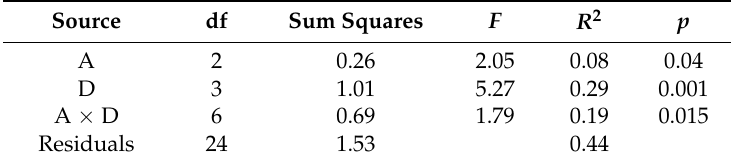
Table 2. Results of permutation multivariate analysis of variance testing (perMANOVA) for the effects of stand age (A), sampling date (D), and their interactions on soil arthropod Order composition.